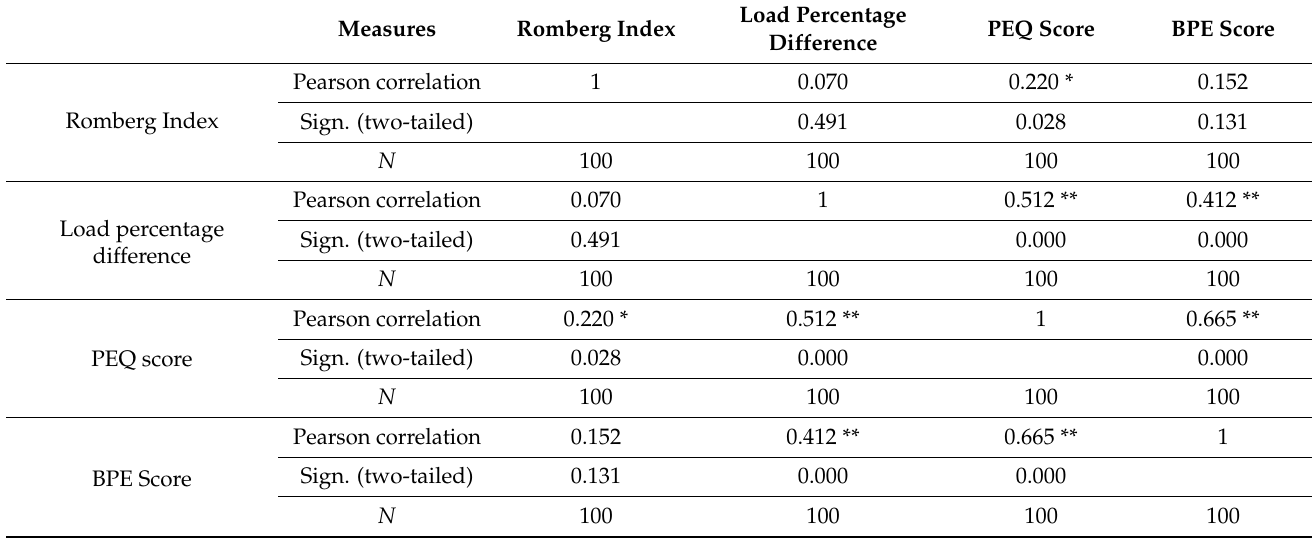
Table 3. Correlation